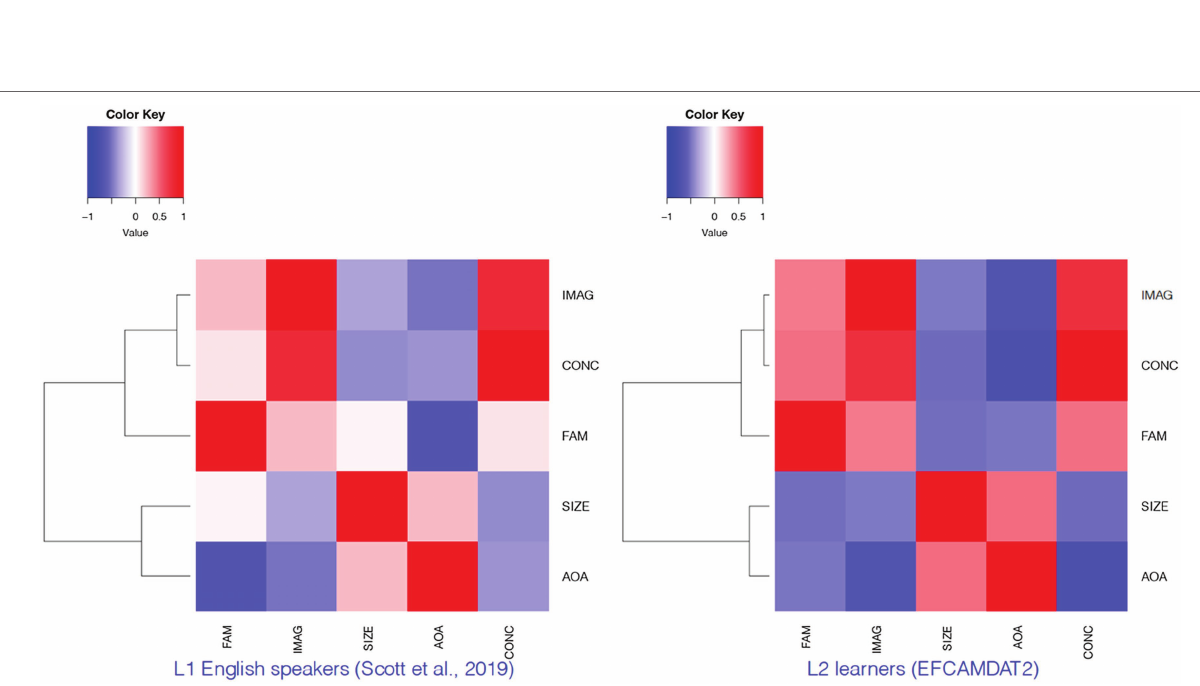
FIGURE 4 | Clusters of LPP dimensions for L1 English speakers and L2 learners. FAM, familiarity; IMAG, imageability; SIZE, semantic size; AoA, age of acquisition; CONC,